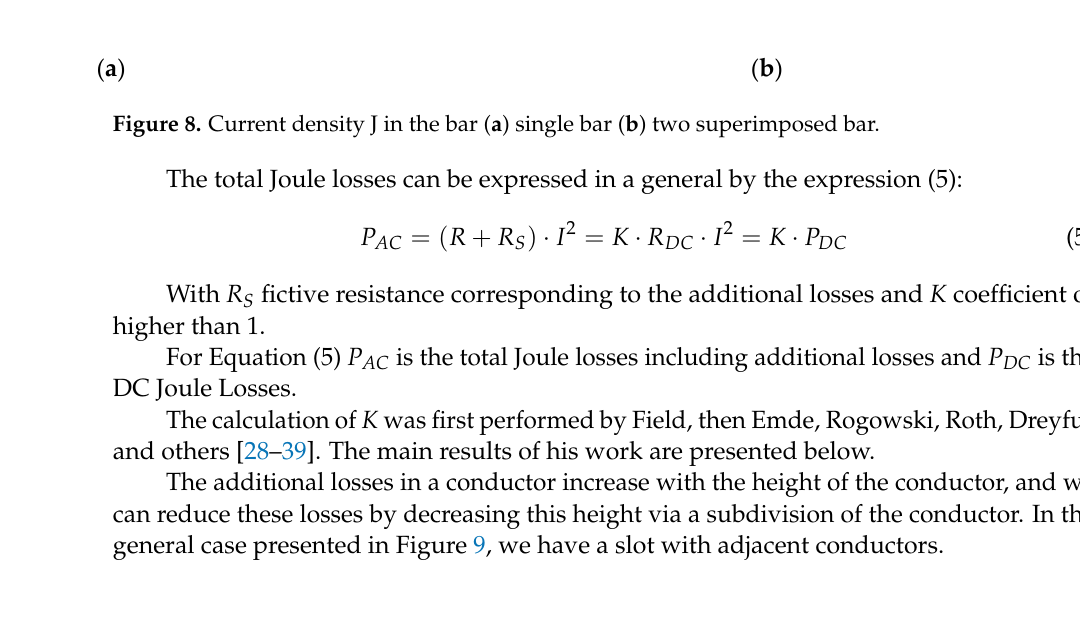
Figure 8. Current density J in the bar ( a ) single bar ( b ) two superimposed bar.